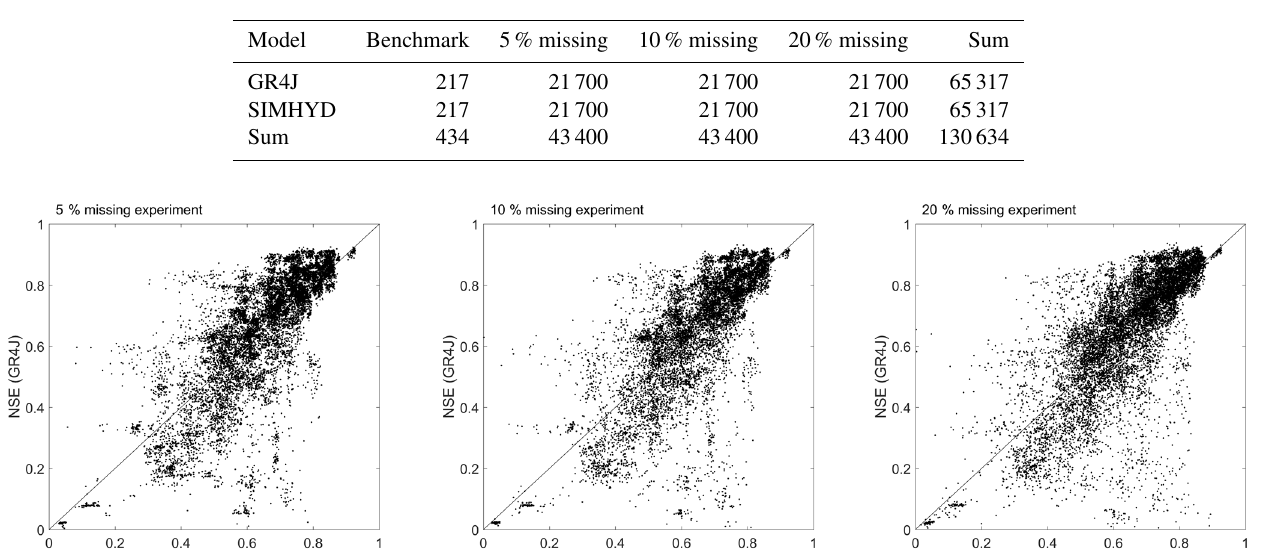
Table 2. Summary of model calibration number carried out for benchmark data and missing data experiments.